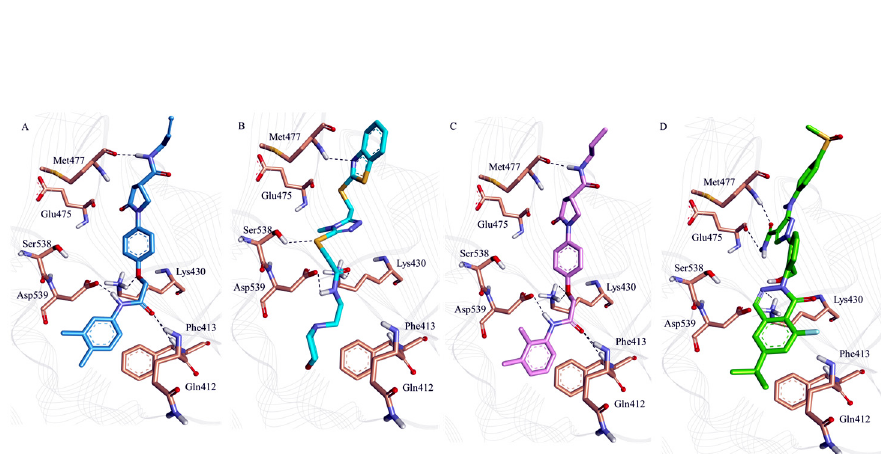
Fig 8. The binding mode of the three hit compounds and reference inhibitor in the active site of Btk. All compounds in their representative structures were superimposed (left) and enlarged (right). The Btk protein is shown in gray color solid ribbon while the compounds are depicted by sticks. Blue, cyan, pink, and green sticks represent Hit1, Hit2, Hit3, and Inhibitor respectively.